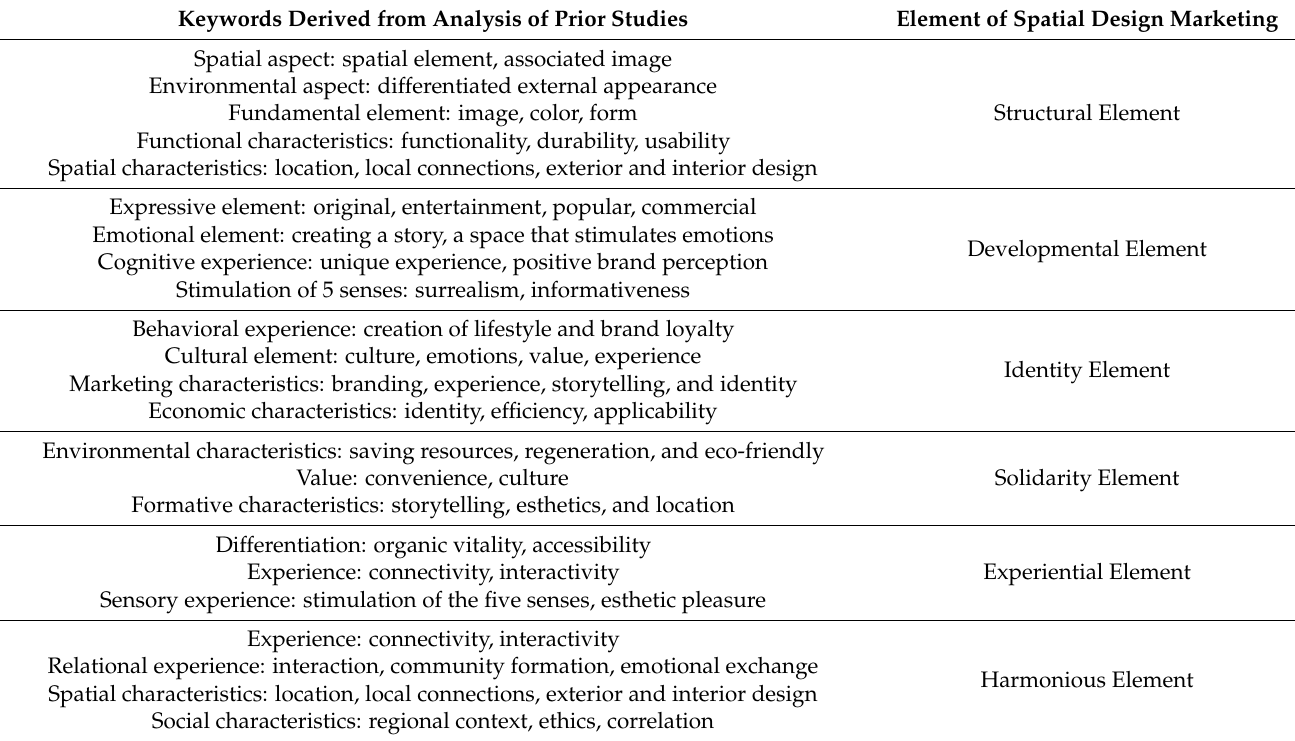
Table 3. Elements of spatial marketing based on an analysis of prior